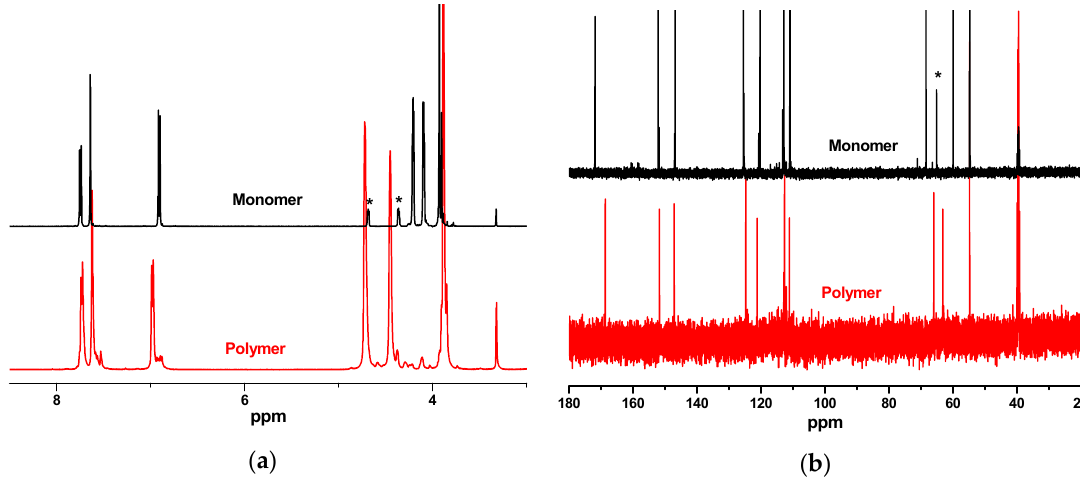
Figure 2. ( a ) 1 H, and ( b ) 13 C NMR spectra of 4-(2-hydroxyethoxy)-3-methoxybenzoic acid and PEV. The solvent peaks have been removed for clarity. Peaks indicated with an asterisk (*) are due to reactions of the monomer in the presence of trifluoroacetic acid (TFA-d).